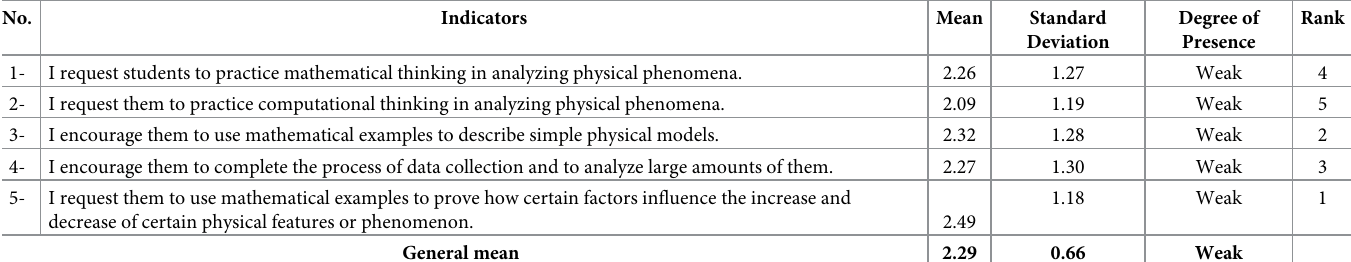
Table 6. The means and standard deviations of the presence of the “using mathematics and computational thinking” practice. No.